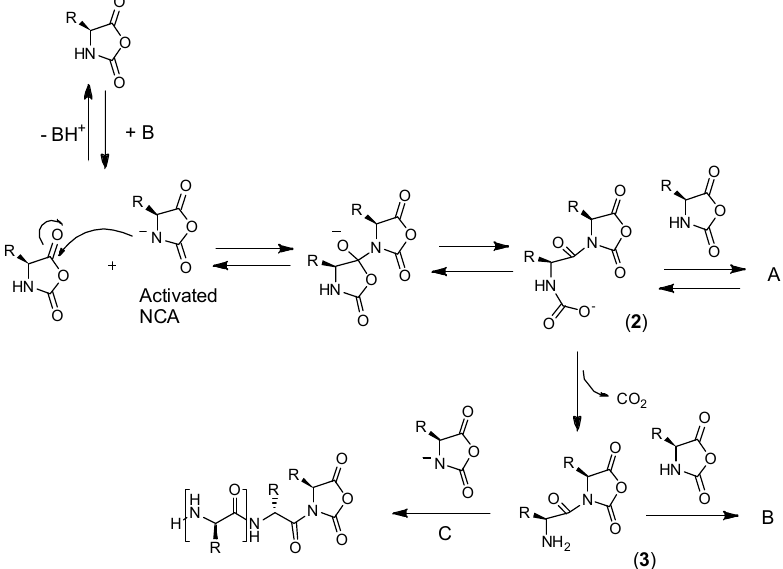
Figure 10. The polymerization of NCAs under the action of aprotic bases is thought to proceed via so-called “activated-monomer mechanism” [22,23].